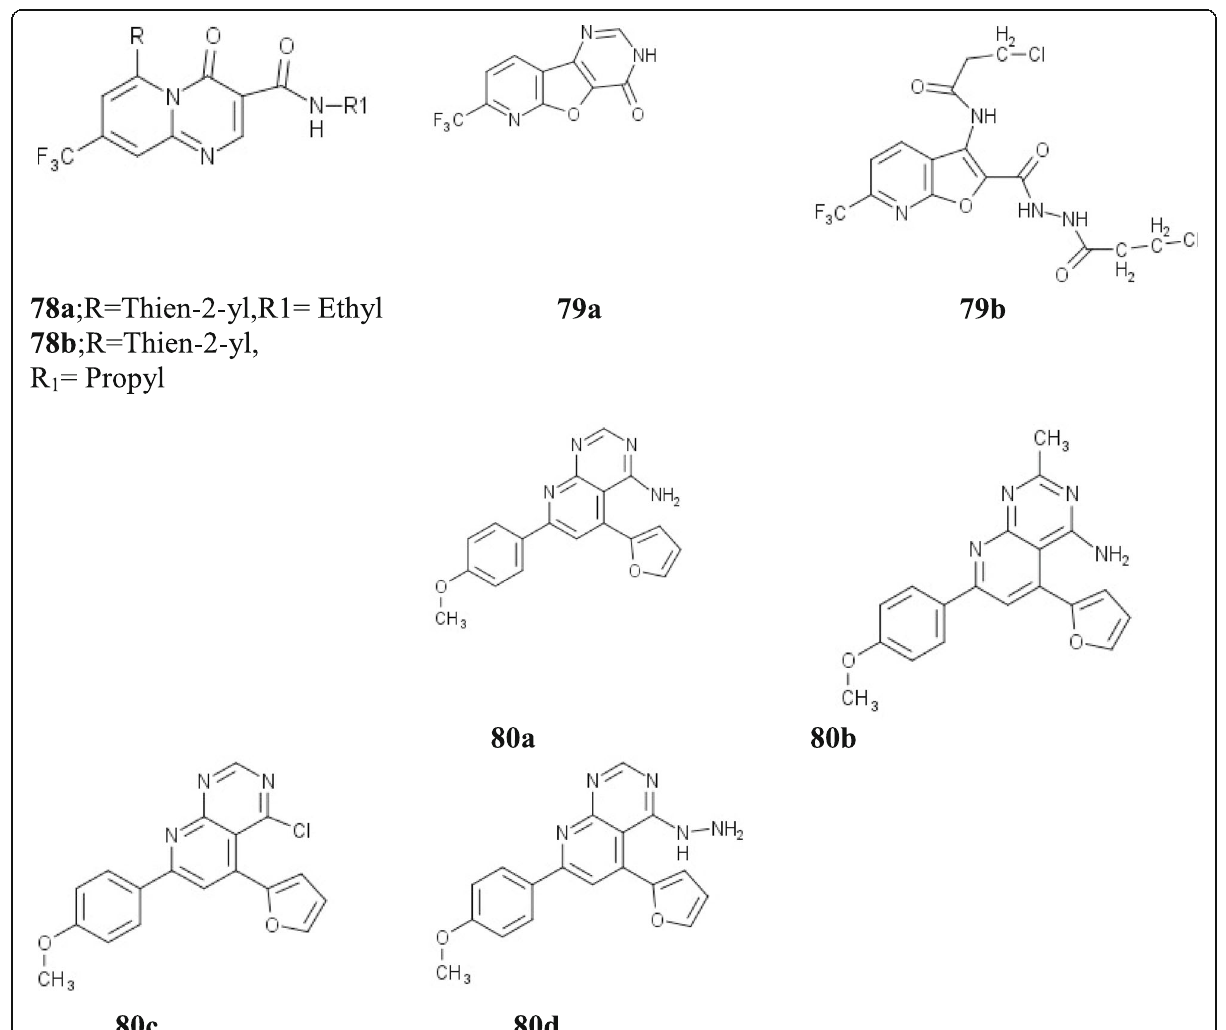
Fig. 26 Chemical structures of pyrido pyrimidine